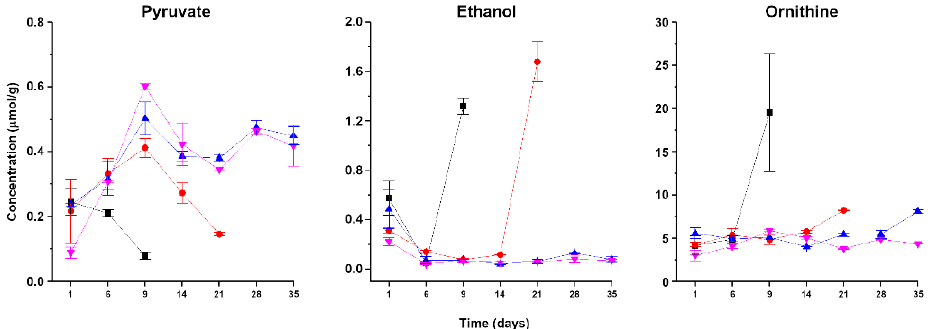
Figure 5. Changes during storage in pyruvate, ethanol, and ornithine concentrations in striped prawn flesh control samples (black squares) and in samples treated with HHP at 400 (red circles), 500 (blue upward triangles), and 600 MPa (purple downward triangles).